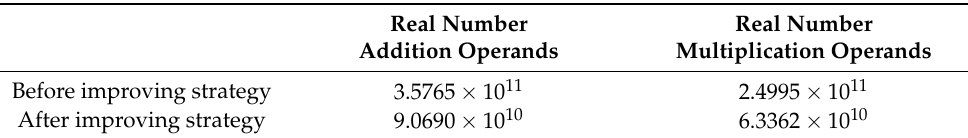
Figure 11. Acquisition time for the phase of the ILS parallel code under different dynamic conditions. Table 3. Comparison of